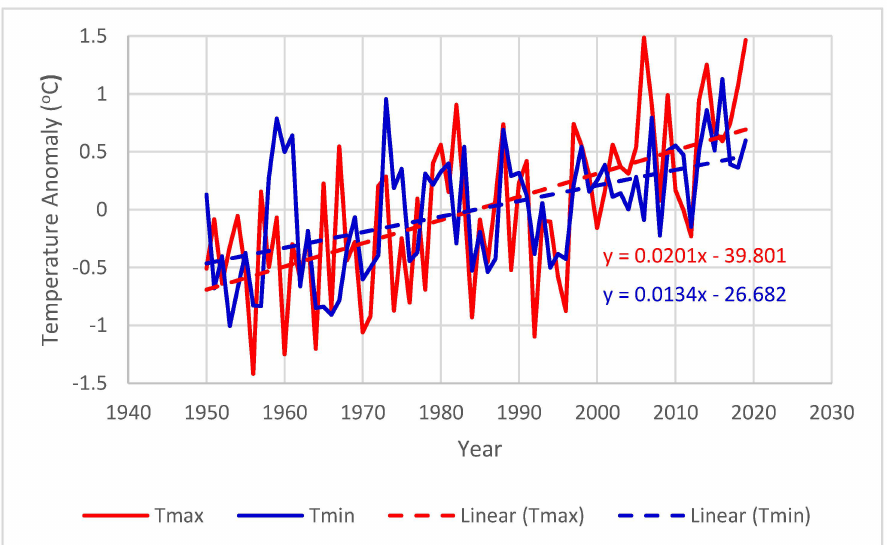
Figure 2. Anomaly of observed (AGCD) annual mean of maximum and minimum temperature and their trends for Australian Alps. The trends are statistically significant using a non-parametric Mann-Kendall test at the 95% confidence